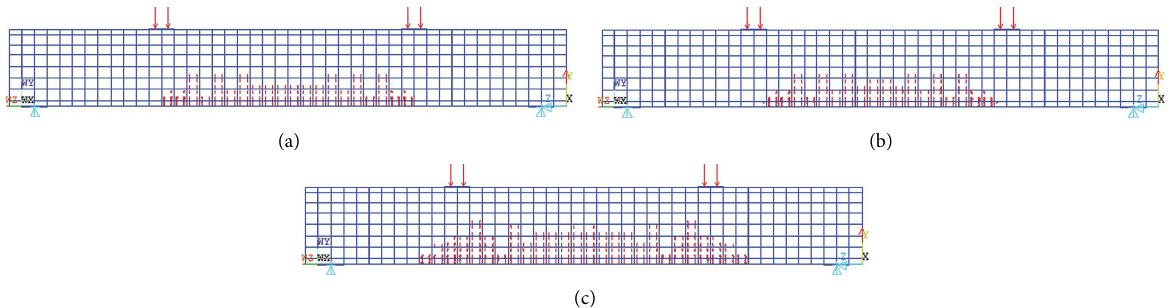
Figure 10: In ANSYS, cracks appear in the beams: (a) cracks begin to appear in the beam ( P the beam ( P crack � 8 kN), μ � 2%; (c) cracks begin to appear in the beam ( P crack � 9kN), μ � 5%.